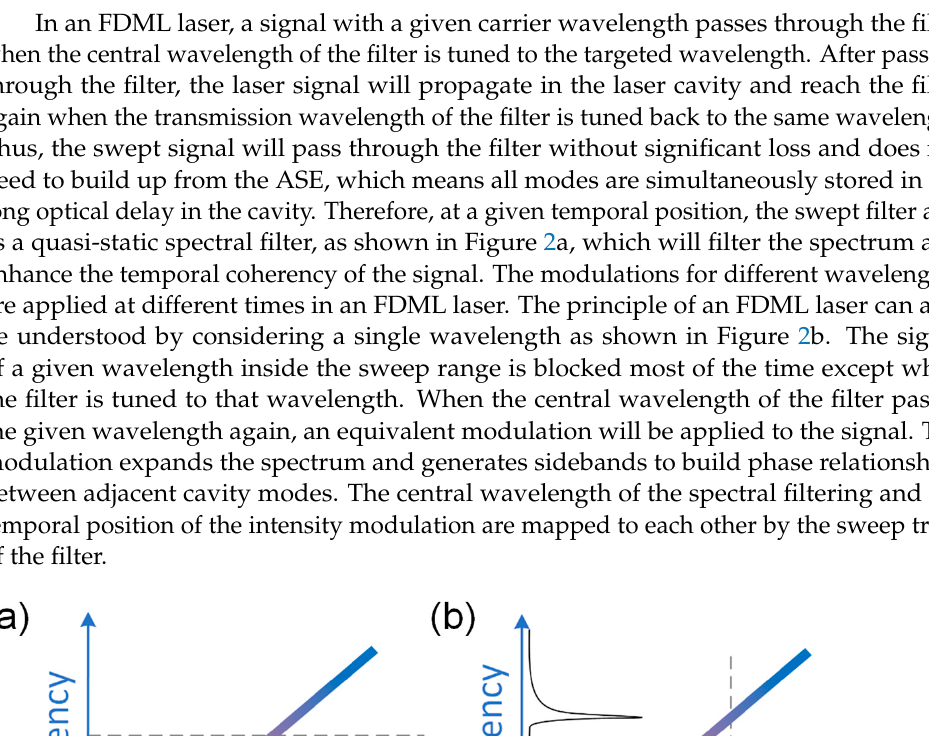
Figure 2. The operation principle of an FDML fiber laser from the viewpoint of ( a ) a single wave- length and ( b ) a given time.